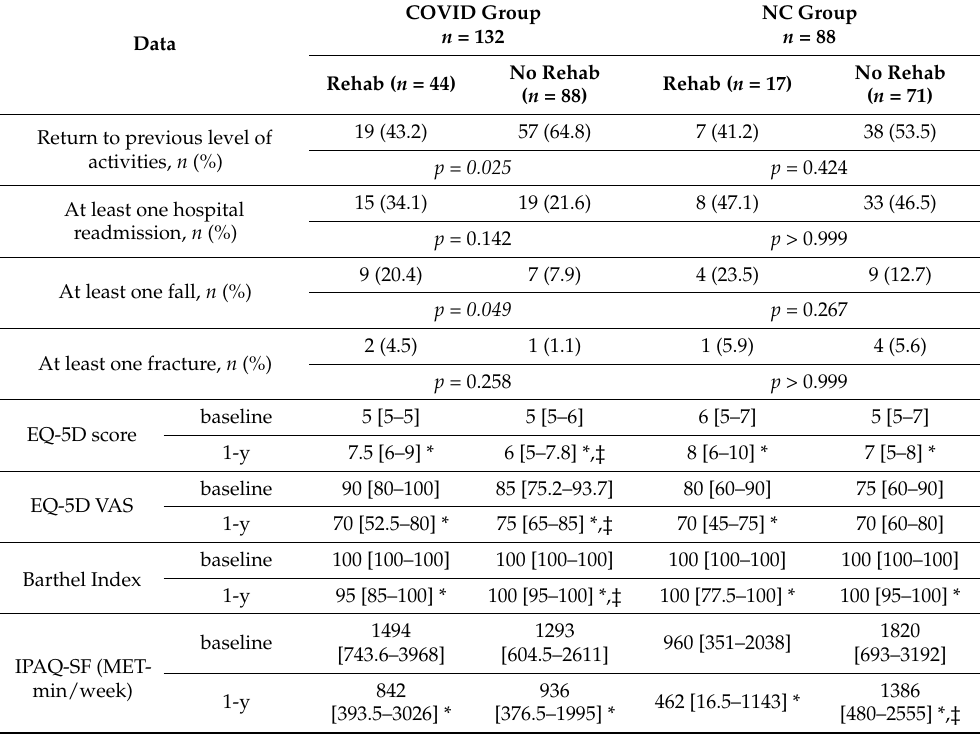
Table 4. One-year outcomes in the COVID and NC groups, whether patients required whether they benefited from rehabilitation after ICU discharge or